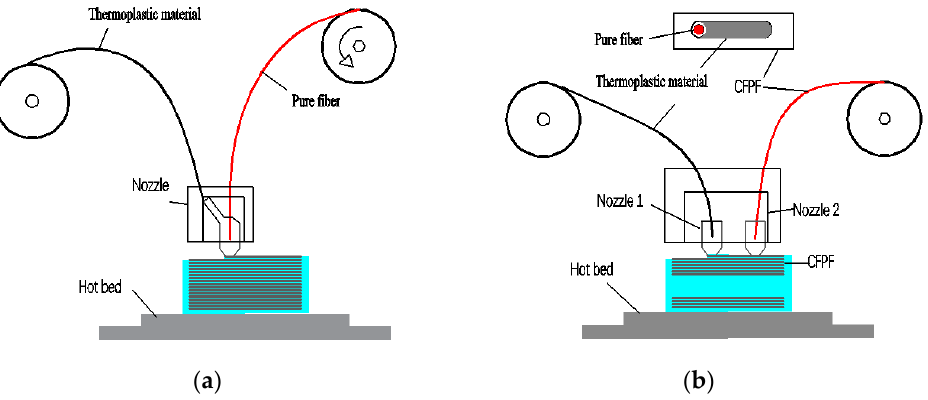
Figure 1. Schematic diagram of CFRC 3DP. ( a ) Type of “ co-extrusion ” . ( b ) Type of “ independent extrusion ” .